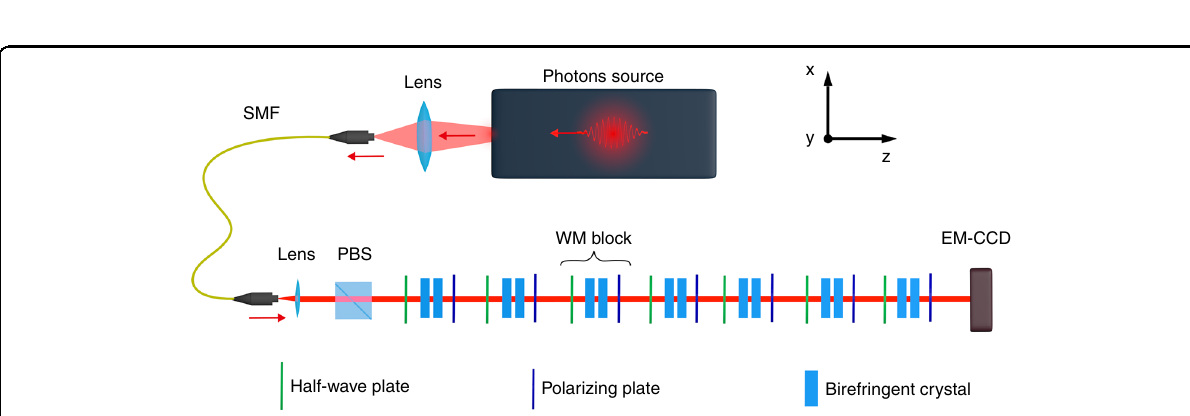
Fig. 4 Experimental setup. Our photon source exploits type-I spontaneous parametric down conversion. Generated signal photons at 702 nm are spectrally- fi ltered, injected in a single-mode fi bre and then collimated in a Gaussian mode to be used in the experiment, while idler photons at 920 nm are detected by a Single-Photon Avalanche Detector in order to monitor the stability of the source. The robust weak measurement is obtained by means of the n = 7 identical blocks put after the initial PBS. A spatially-resolving detector (EM-CCD camera operating in the photon counting regime) is used to determine the fi nal position of the detected photons